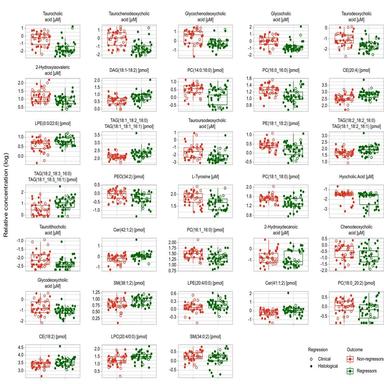
Statistically significant lipids/metabolites differentiating non-regressors (red) vs. regressors (green) in the discovery cohort. The markers were associated with regression, with and without the presence of histological regression. The association of each marker is tested by an analysis of deviation of a logistic regression and corrected for multiple-testing by the estimation of Benjamini-Hochberg false discovery rate <−5%. CE, cholesterol ester; DAGs, diacylglycerides; LPE, lysophosphatidylethanolamine; L